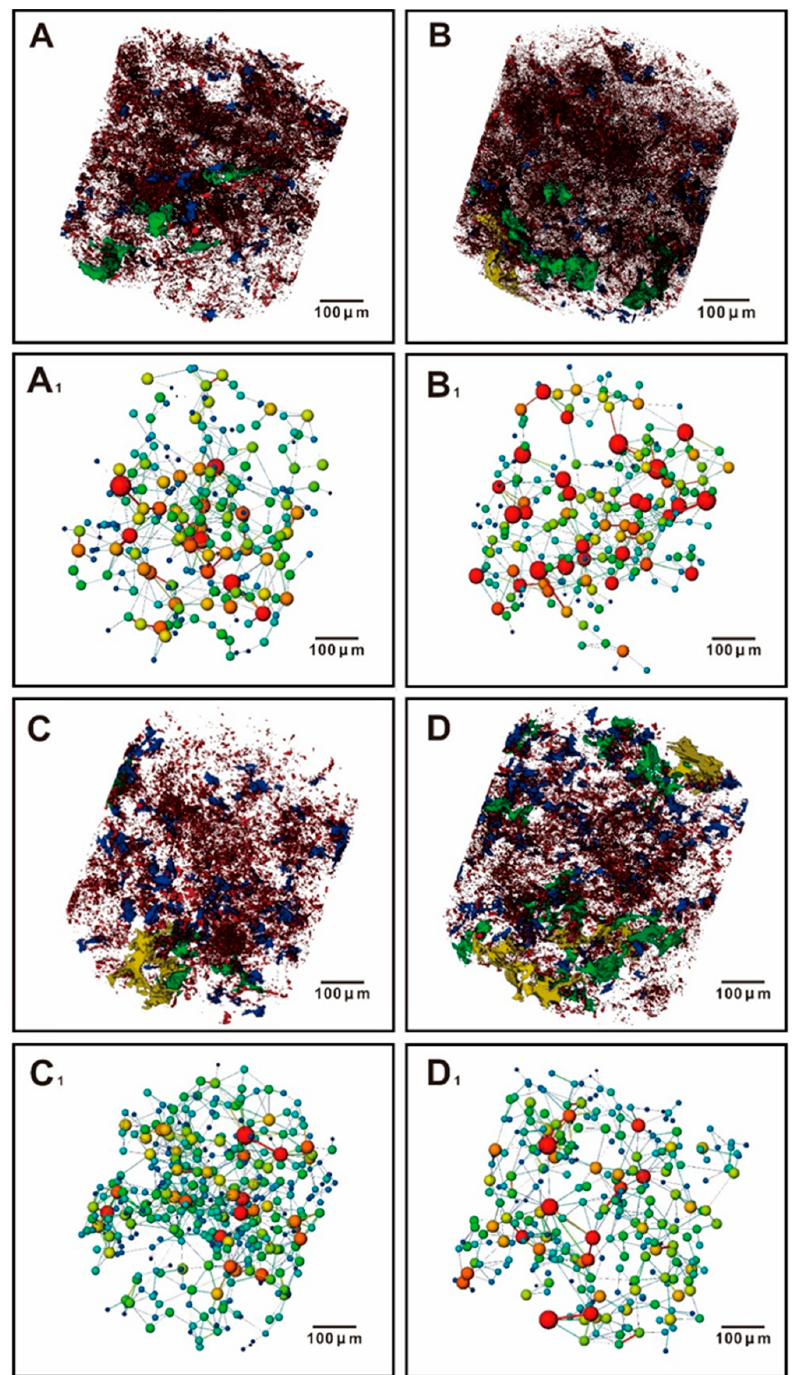
Figure 9. Three-dimensional model of pore system for samples A-130 and Q-148: ( A ) pore space of sample A-130 before experiment; ( B ) pore space of sample A-130 after the experiment; ( C ) pore space of sample Q-148 before experiment; ( D ) represents the pore space of the Q-148 after the experiment. The red parts represent pores with an equivalent diameter of 0–20 µm, the blue parts represent pores with an equivalent diameter of 20–50 µm, the green parts represent pores with an equivalent diameter of 50–100 µm, and the yellow parts represent pores with an equivalent diameter of 100 µm~200 µm. ( A 1 ) Pore connectivity of sample A-130 before the experiment, ( B 1 ) Pore connectivity of sample A-130 after the experiment; ( C 1 ) Pore connectivity of sample Q-148 before experiment; ( D 1 ) Pore connectivity of sample Q-148 after the experiment. The red, yellow, green, and blue represent the strong to weak connectivity between pores.